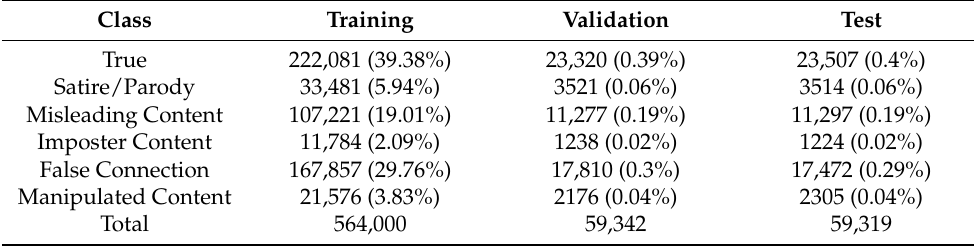
Table 2. Class distribution for the multimodal